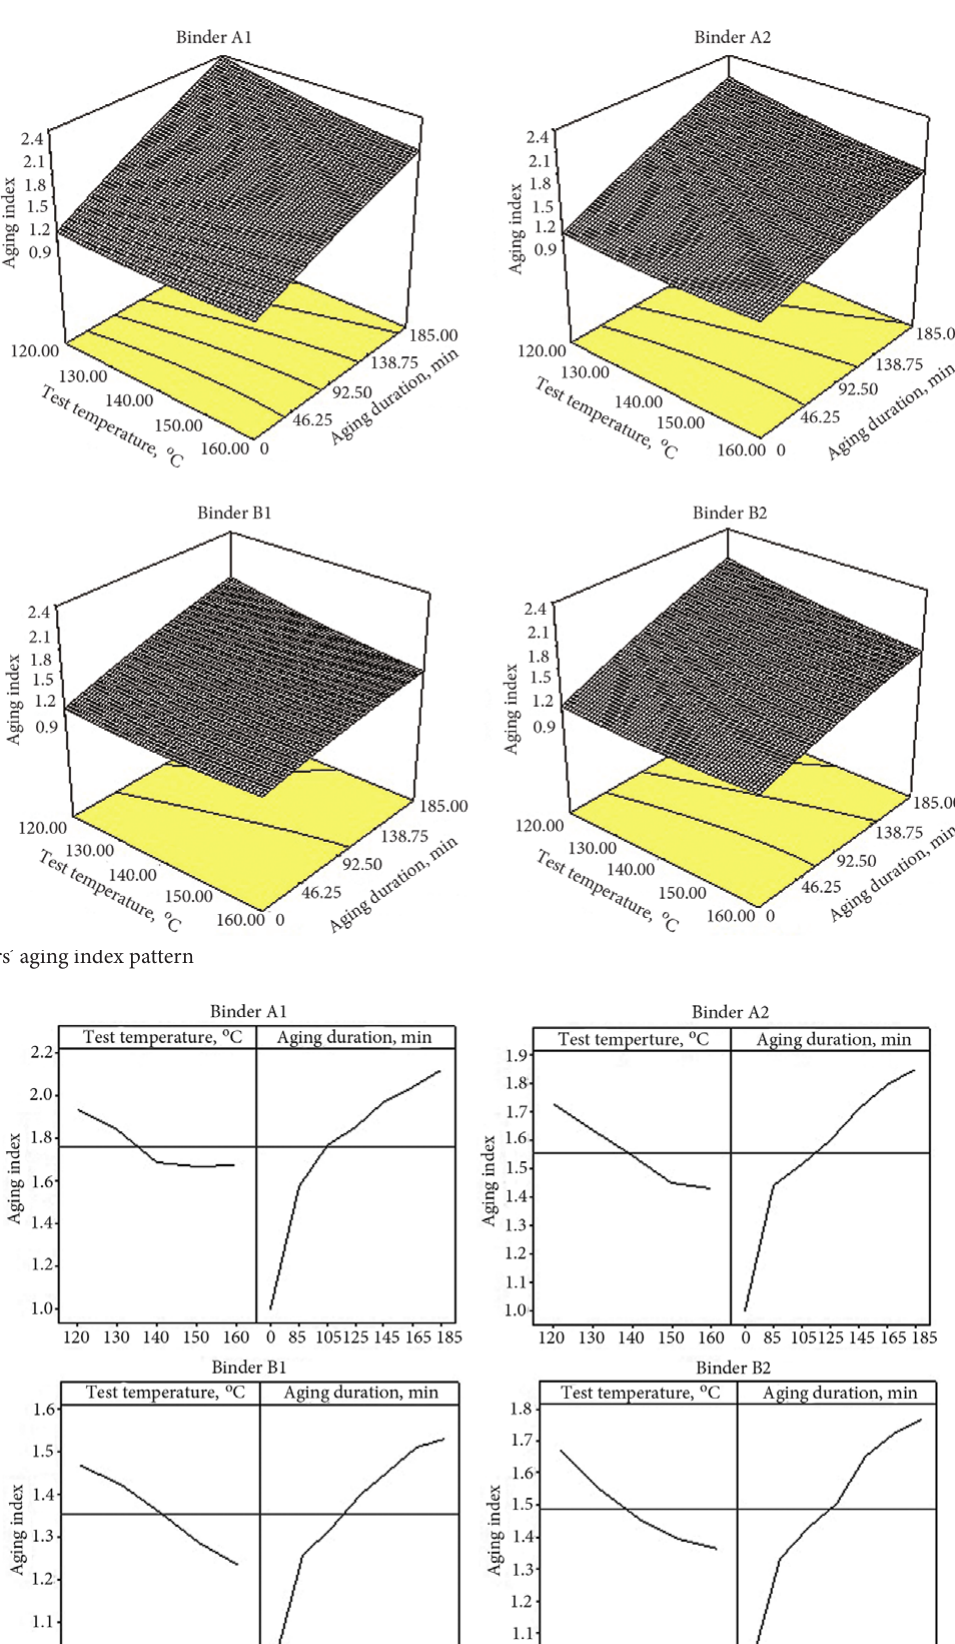
Fig. 4. The main effects of test temperature and aging duration on aging